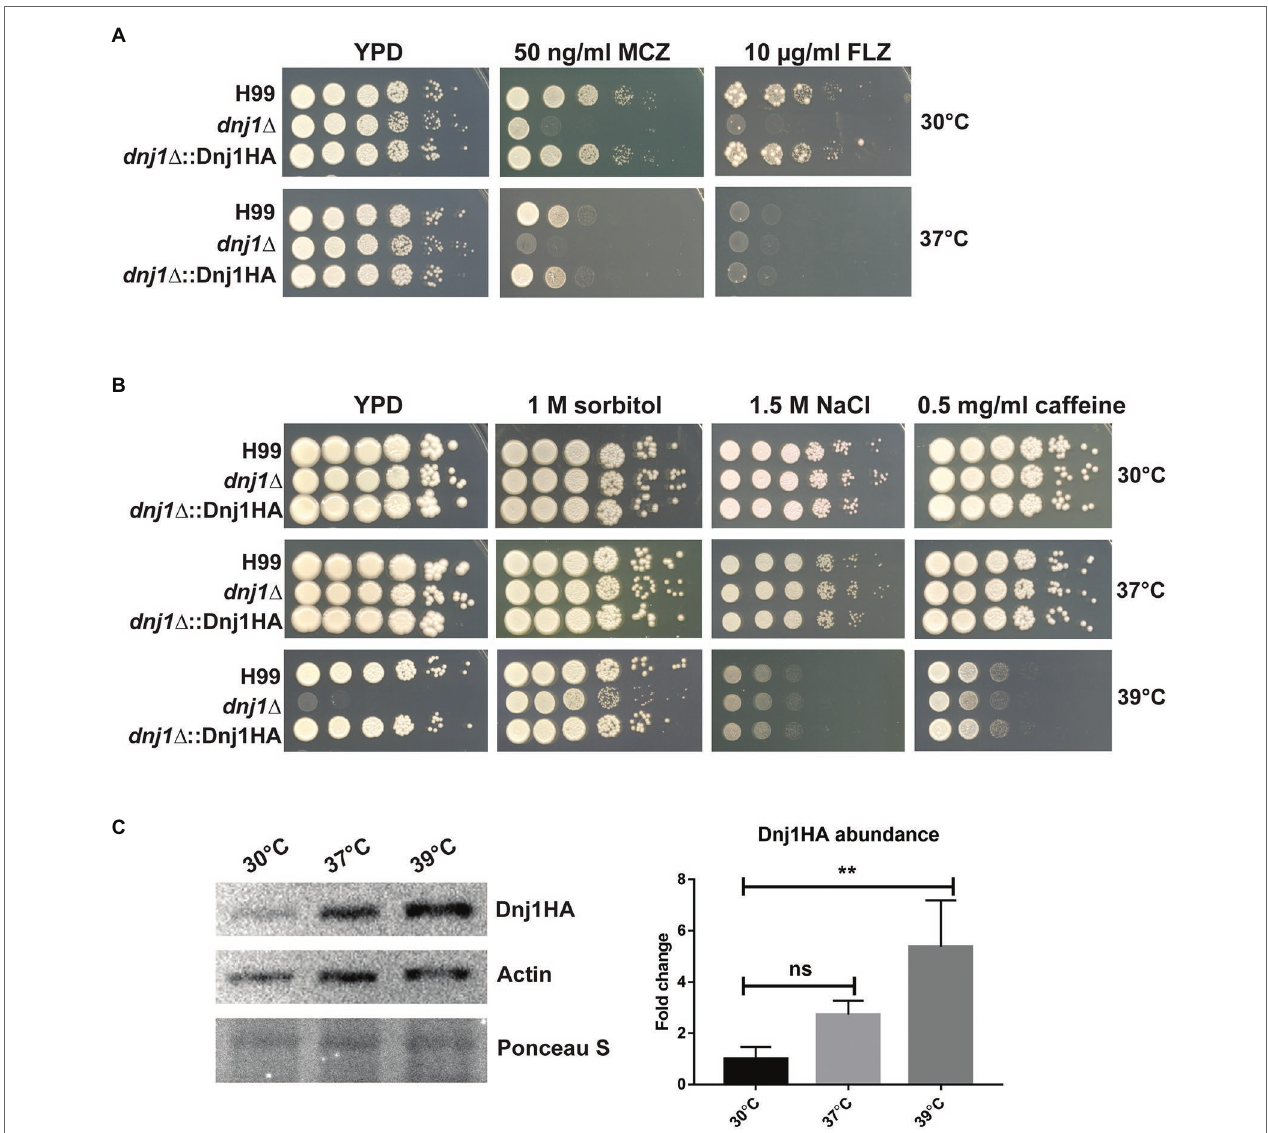
FIGURE 4 | Dnj1 impacts sensitivity to azoles, cell wall stress, and temperature stress. Spot assays of serially diluted Cryptococcus neoformans wild type (H99), dnj1 ∆ mutant, and complemented ( dnj1 ∆ ::Dnj1HA) strains were performed on YPD supplemented with the indicated stressors and incubated at 30, 37, or 39 ° C to assess hypersensitivity. (A) The sensitivity of the dnj1 ∆ mutant to the antifungal azole drugs, fluconazole (FLZ), and miconazole (MCZ), at the indicated concentrations in YPD agar, was assessed at both 30 and 37 ° C. (B) The impact of agents that provoke osmotic and cell wall stress on the growth of the dnj1 ∆ mutant was evaluated at 30, 37, and 39 ° C in YPD supplemented with the indicated concentrations of these stress-inducing agents. For all spot assays, plates were incubated for 2–5 days at the indicated temperature before being scanned. The spot assays shown are representative of at least three independent replicates. (C) Detection of the abundance of Dnj1HA in response to temperature stress by immunoblot analysis. The blot was also probed for actin to allow relative quantification and Ponceau S stained to ensure equal protein loading. This blot is representative of three experiments that established the relative abundance of the Dnj1HA protein. The bar heights indicate the mean of three replicated and error bars indicate the SD. Statistical significance was determined using a one-way ANOVA with Dunnet’s multiple comparison tests (** p <